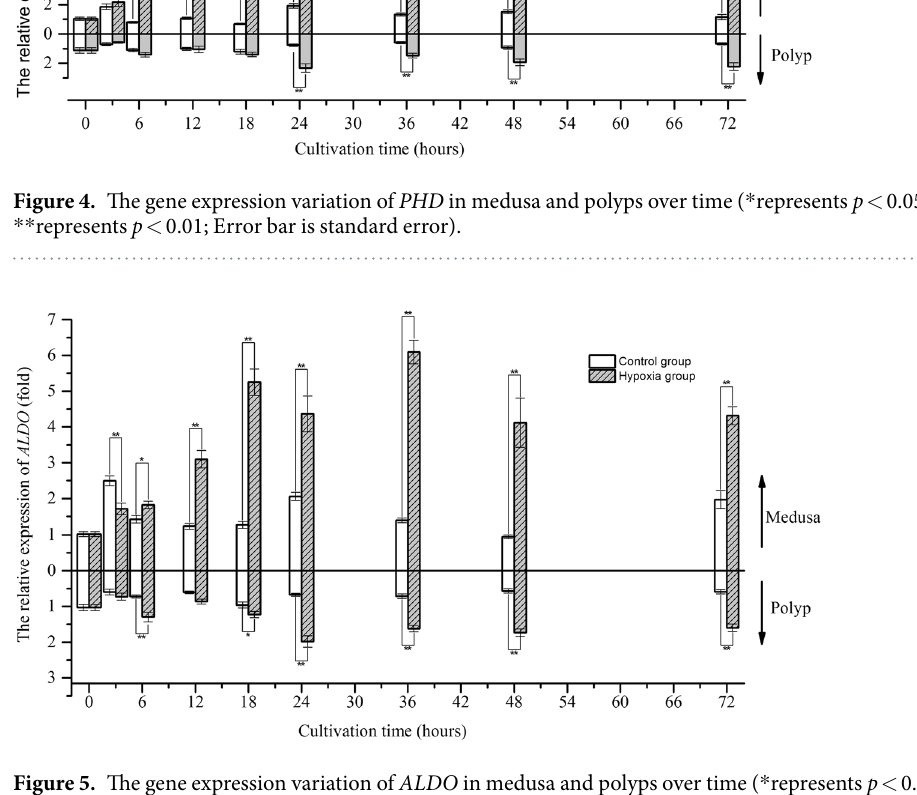
Figure 5. The gene expression variation of ALDO in medusa and polyps over time ( * represents p < 0.05 and ** represents p < 0.01; Error bar is standard